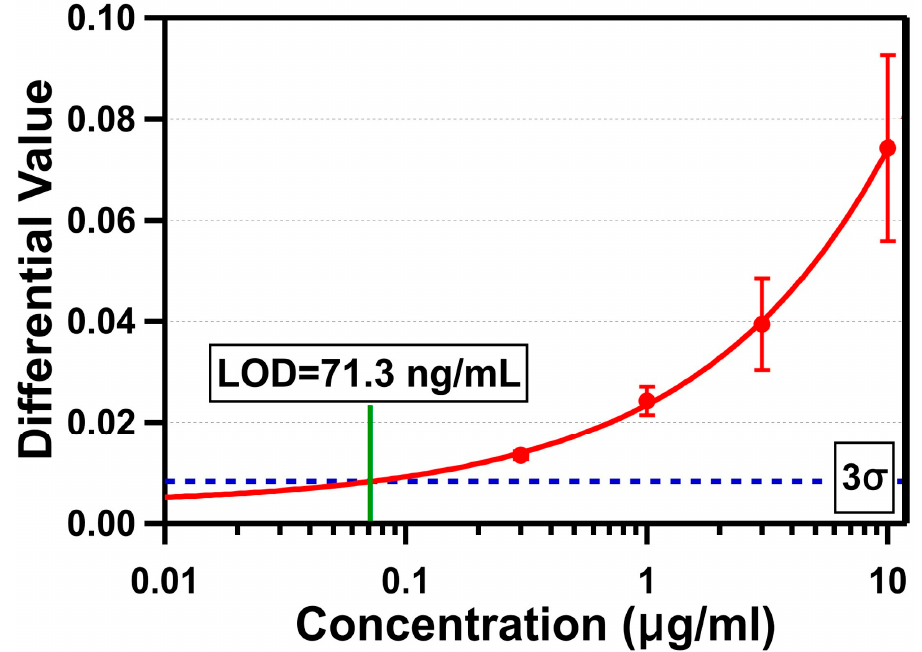
Figure 6. Differential values measured in triplicate versus four concentrations of streptavidin in a log scale.